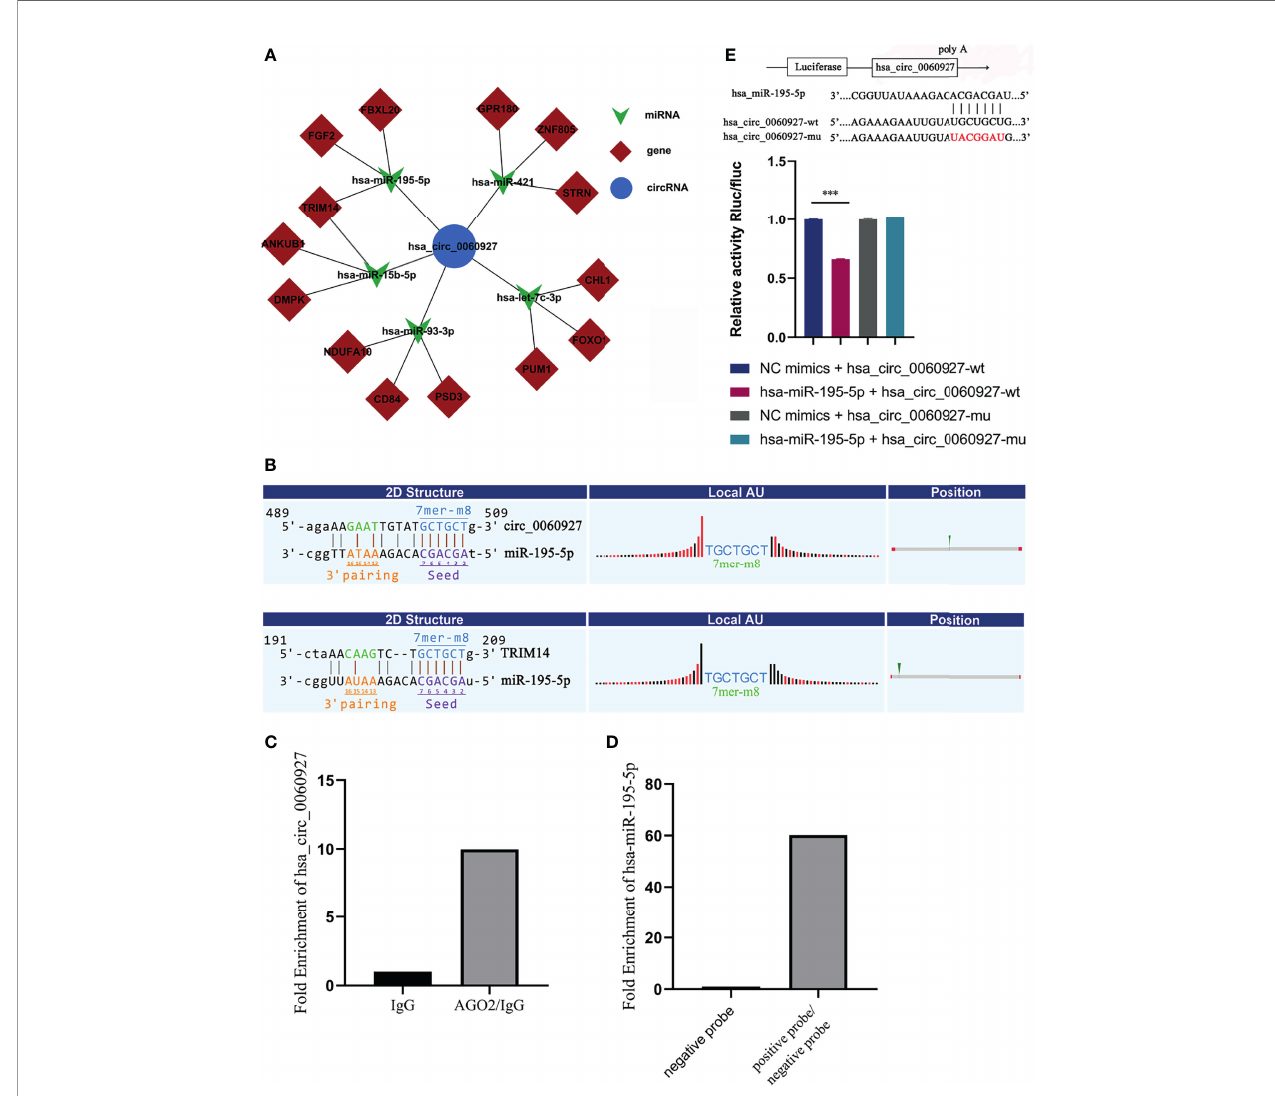
FIGURE 6 | Hsa_circ_0060927 functioned as a sponge for miR-195-5p. (A) ceRNA networkpredicted downstream miRNA and mRNA of hsa_circ_0060927. (B) The online software revealed the potential binding site between hsa_circ_0060927/miR-195-5pand TRIM14/miR-195-5p. (C) RIP assay. (D) RNA pull-down assay. (E)